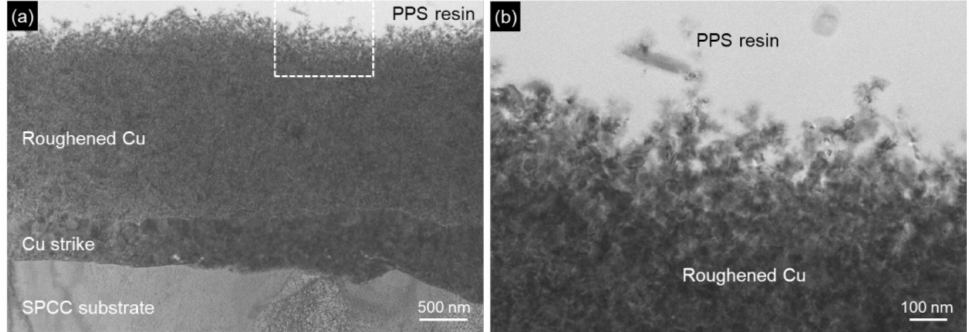
Figure 7. Cross-sectional scanning transmission electron microscopy (STEM) images of sample D: